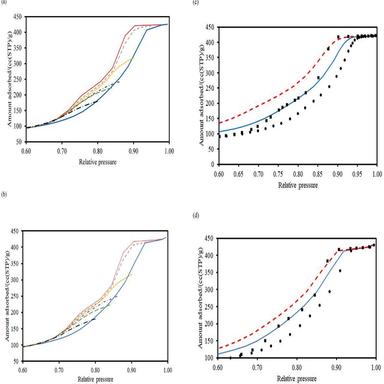
Boundary nitrogen adsorption (blue thick solid line) and desorption (red thin solid line) isotherms, and desorption scanning curves starting at relative pressures of 0.95 (grey dashed line), 0.90 (yellow dotted line), 0.86 (purple short dash-dot line), 0.84 (green dash line), 0.80 (black long dash-dot line), for whole pellet (a) and powder (b) forms of alumina extrudate E2. (STP = standard temperature and pressure). Analysis of the hysteresis width between boundary adsorption (●) and desorption (■) isotherm